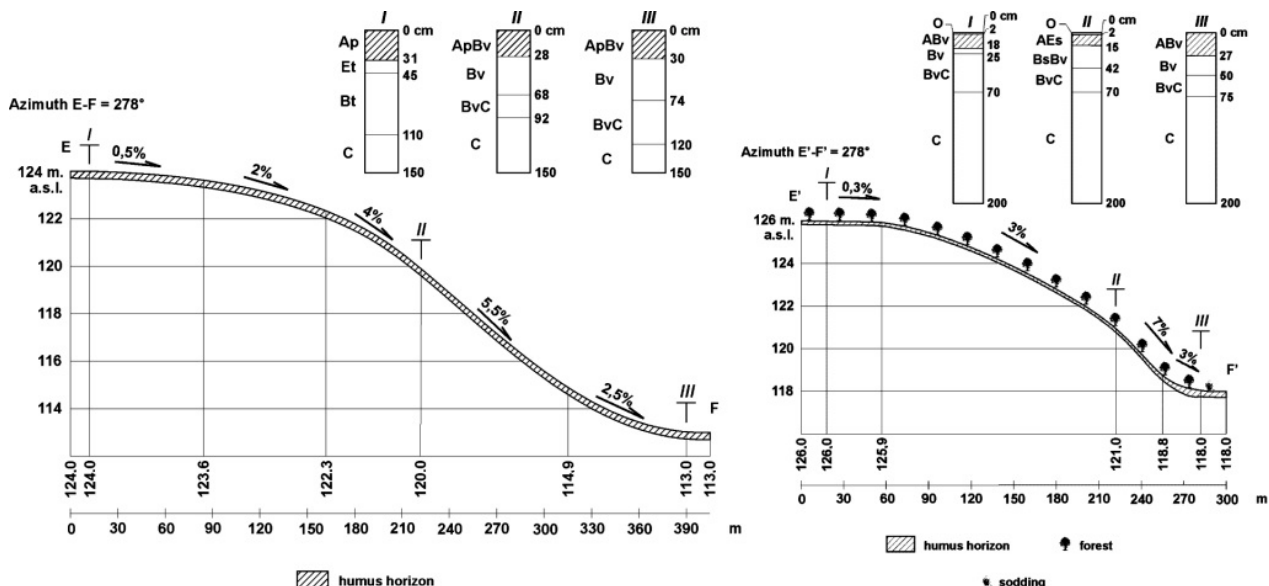
Figure 3. The soil cross sections E-F and E’-F’. Slope gradient in %; A: humus horizon; E: eluvial horizon; B: enrichment horizon; C: parent material (substratum); O: organic horizon; p : plow layer; t (for E horizons): leaching of clay fraction; t (for B horizons): illuvial accumulation of clay; v: occurrence of plinthite; s: iron and aluminium leaching [39].